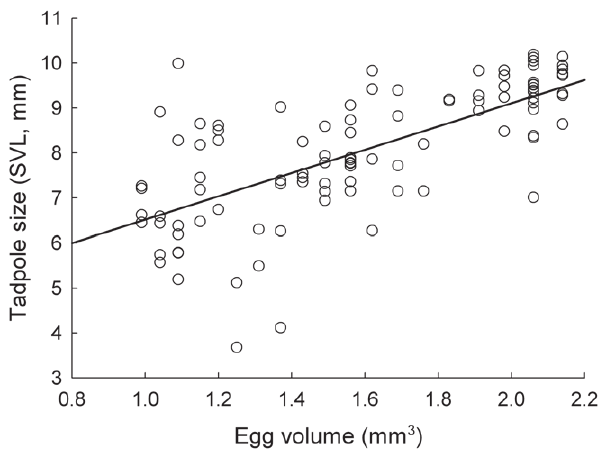
Figure 4. The relationship between egg volume and tadpole body size. Shown is egg volume and tadpole body size (SVL) measured at seven days after oviposition, for 102 S. multiplicata individuals from four